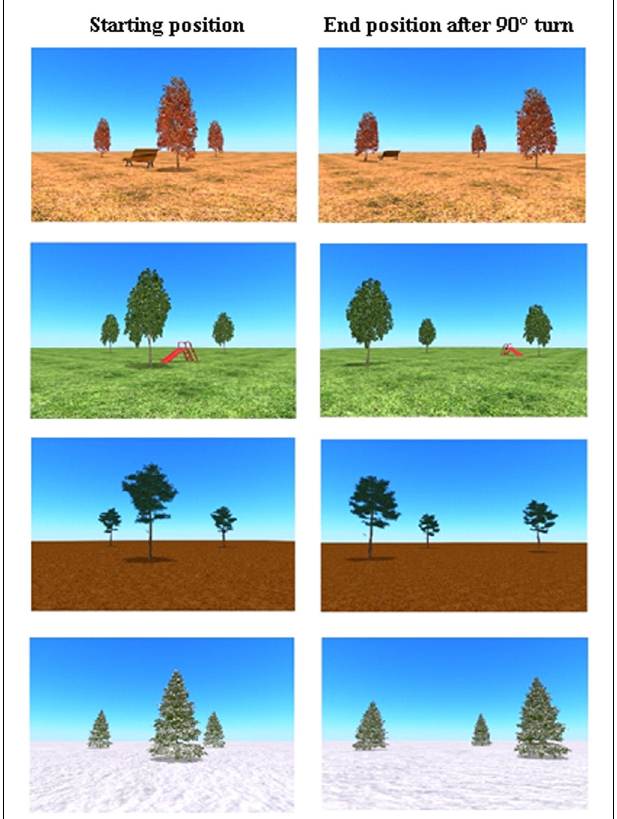
FIGURE 1 | Overview of the four environments, with and without landmark and a reproduction of the spatial transformation in the virtual spatial memory task. The direction of the turn is respectively right, left, left,